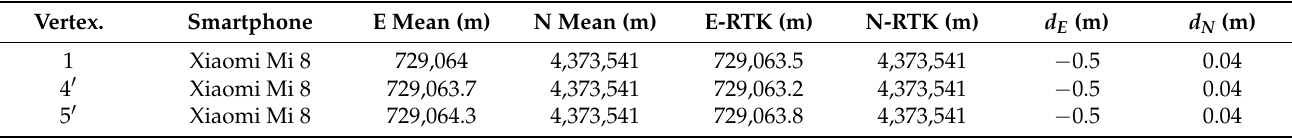
Table 6. Vertices 1, 4 (cid:48) , and 5 (cid:48) : East, North coordinates obtained from Equation (27), East, North coordinates from real-time GNSS techniques (E-RTK, N-RTK), and the differences between ( d E , d N ).